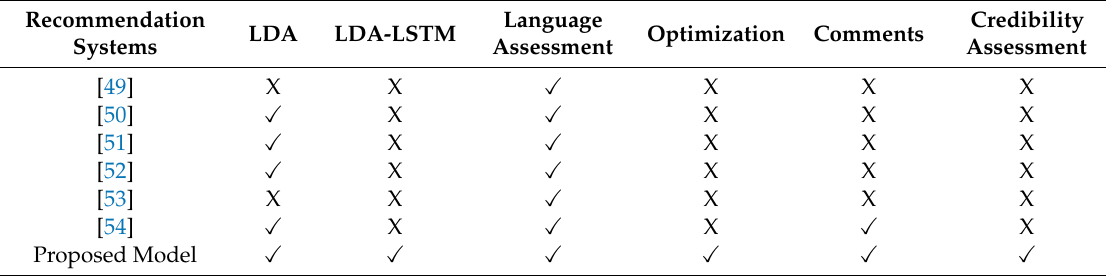
Table 13. Comparison of our proposed approach with existing recommender